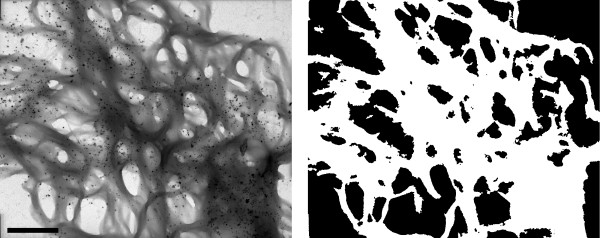
Segmentation of the fibrils. After background removal and segmentation, small particles (nanoparticles showing as black dots in the left image) have been removed. The scale bar corresponds to approximately 1 μm.